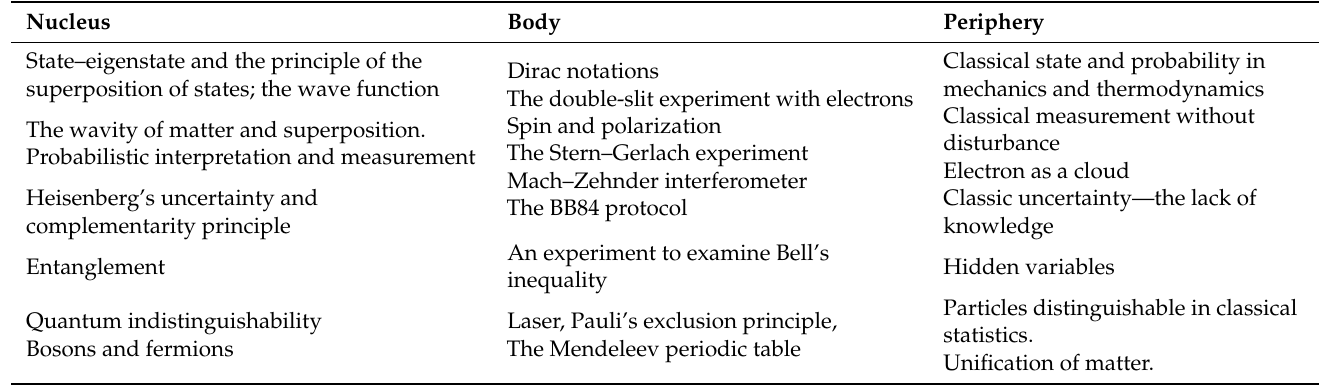
Table 3. An example of DC-type of curricular structure of QP in high school. See text for